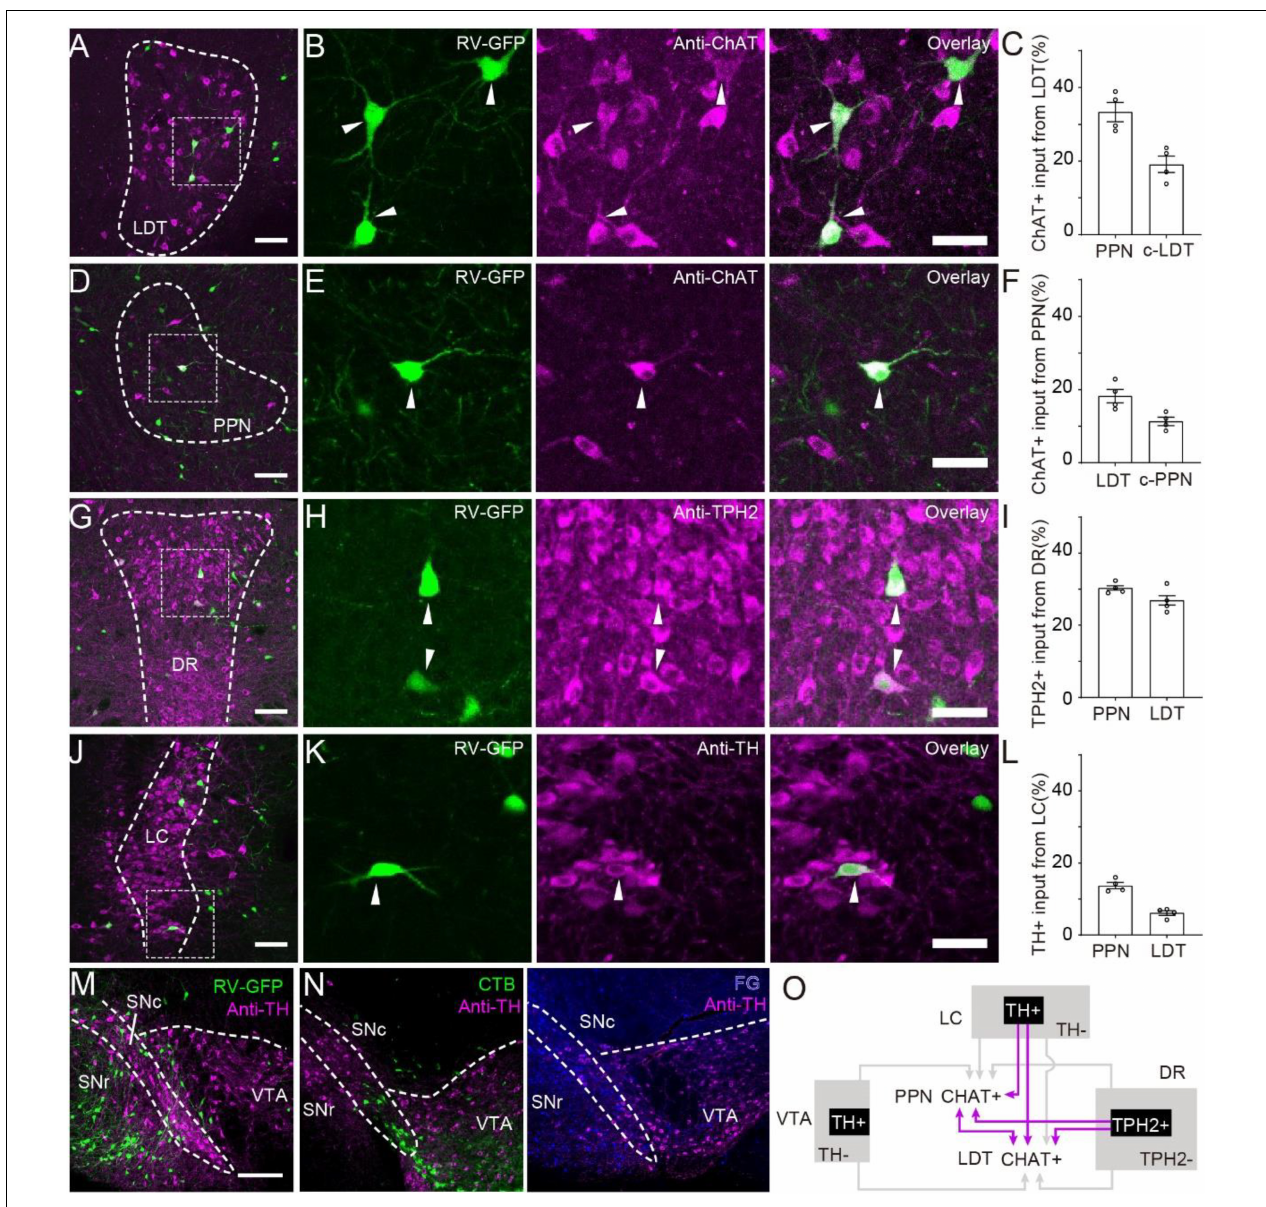
FIGURE 2 | Monosynaptic afferent from neuromodulator neurons. (A) Immunohistochemical staining of input from LDT to PPN. (B) A three-panel presentation with RV, anti-ChAT, and overlay; arrows point out ChAT-positive input neurons. (C) Proportion of ChAT+ neurons input from LDT to PPN. (D) Immunohistochemical staining of input from PPN to LDT. (E) A three-panel presentation with RV, anti-ChAT, and overlay; arrows point out ChAT-positive input neurons. (F) Proportion of ChAT-positive neurons input from PPN to LDT. (G) Immunohistochemical staining of input neurons in the DR. (H) A three-panel presentation with RV, anti-TPH2, and overlay; arrows point out TPH2-positive input neurons. (I) Proportion of TPH2+ neurons input from DR to PPN or LDT. (J) Immunohistochemical staining of input neurons in the LC. (K) A three-panel presentation with RV, anti-TH, and overlay; arrows point out TH-positive input neurons. (L) Proportion of TPH2+ neurons input from DR to PPN or LDT. (M,N) Immunohistochemical staining of input neurons in the VTA labeled with RV, CTB, and FG, respectively. (O) The interconnections between PMT cholinergic neurons and neuromodulatory nuclei. The abbreviations of nuclei suffixed with “-c” meant nuclei in the contralateral. A scale bar − (A,D,G,J,M,N) 200 µ m; (B,E,H,K) 50 µ m. Data are shown as mean ± SEM. PPN = LDT = 4